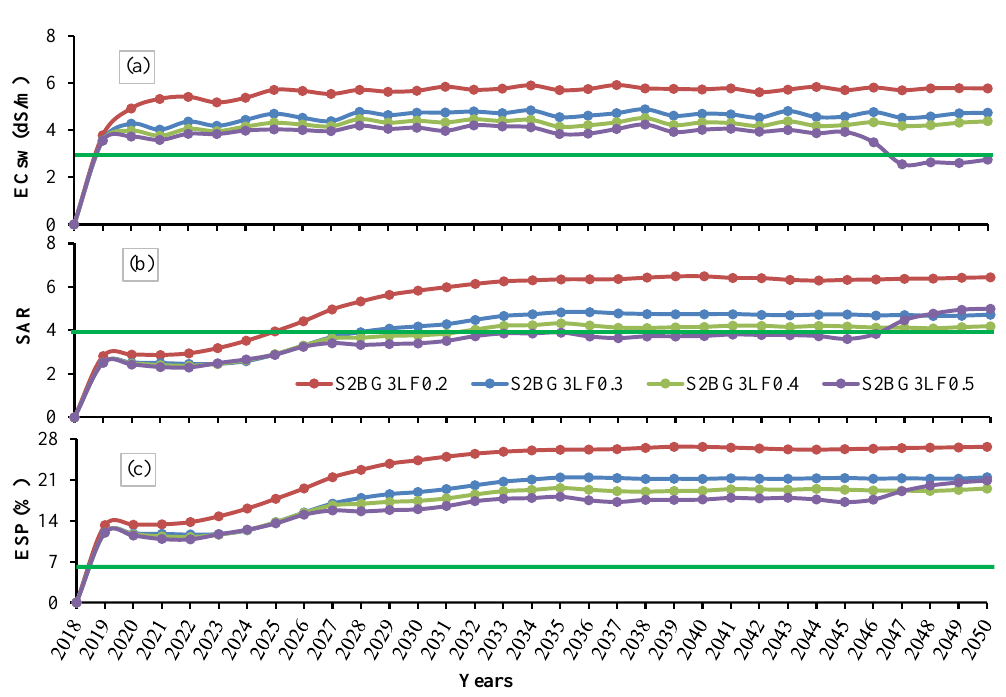
Figure 15. Impact of different leaching fractions (LF0.2, LF0.3, LF0.4, and LF0.5) and annual gypsum applications of 8.6 t/ha (G3) on ( a ) ECsw, ( b ) SAR, and ( c ) ESP in the 90–120 cm soil layer of the hard red-brown soil (S2) under a 1:1 blend of recycled (RW) and good water (GW) irrigation of almonds.